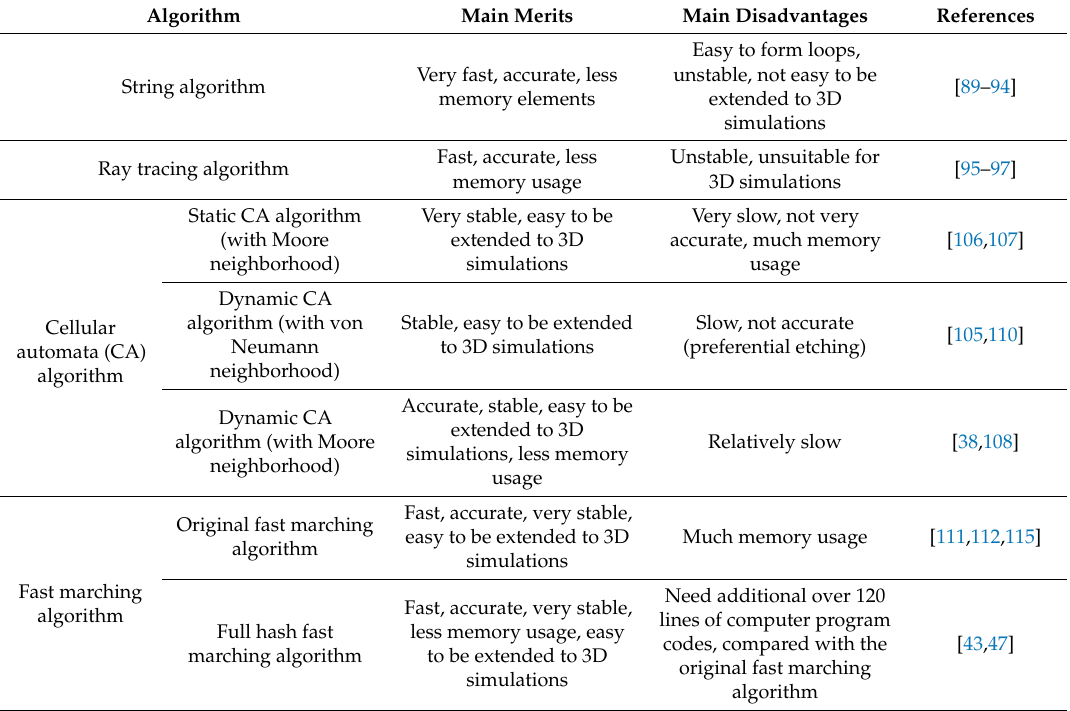
Table 1. Feature comparisons of different etching surface advancement algorithms for the ultraviolet (UV) lithography simulation of the